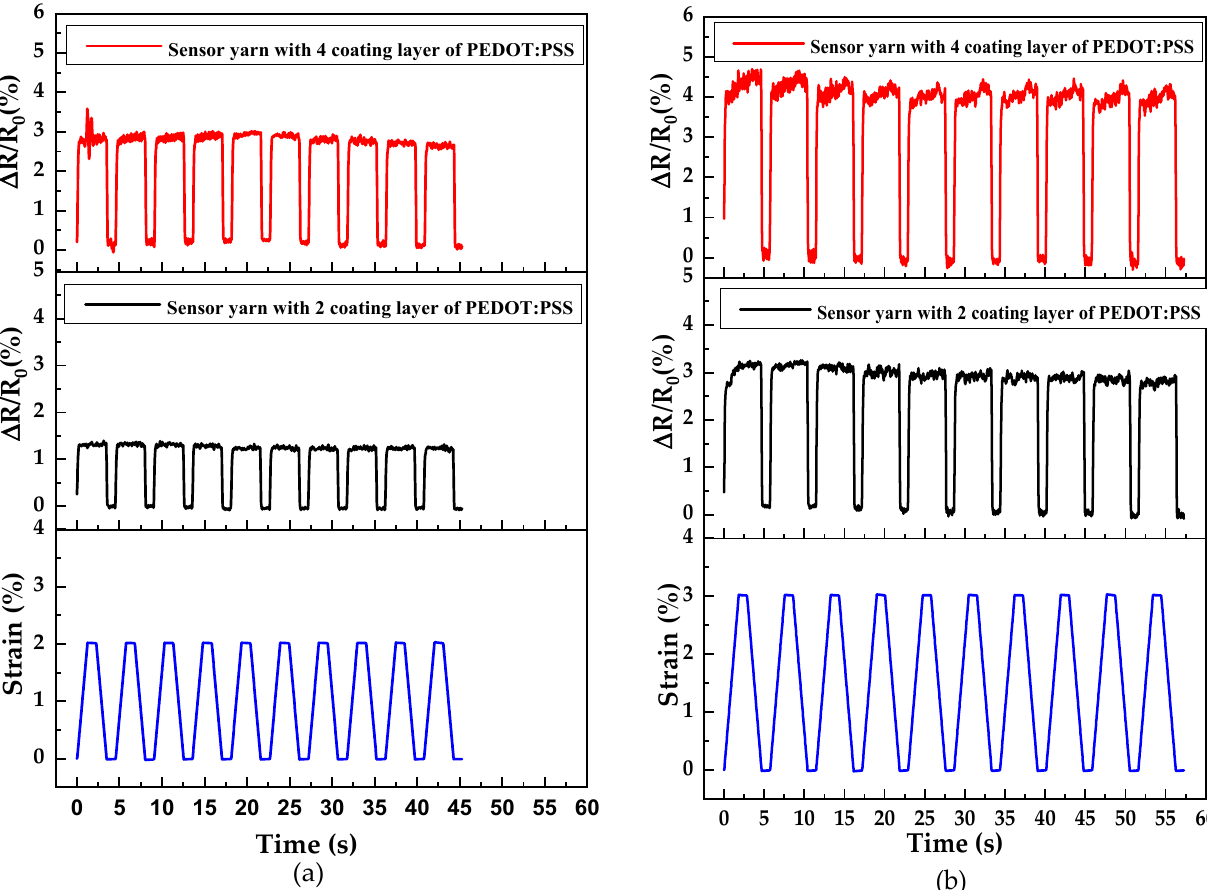
Figure 9. The relative variation of resistance ( ∆ R/R 0 ) as a function of time under cyclic tensile load–unload for sensor yarns with different numbers of PEDOT:PSS-coated layers, for two ranges of strain between: ( a ) 0% and 2%; and ( b ) 0% and 3%.